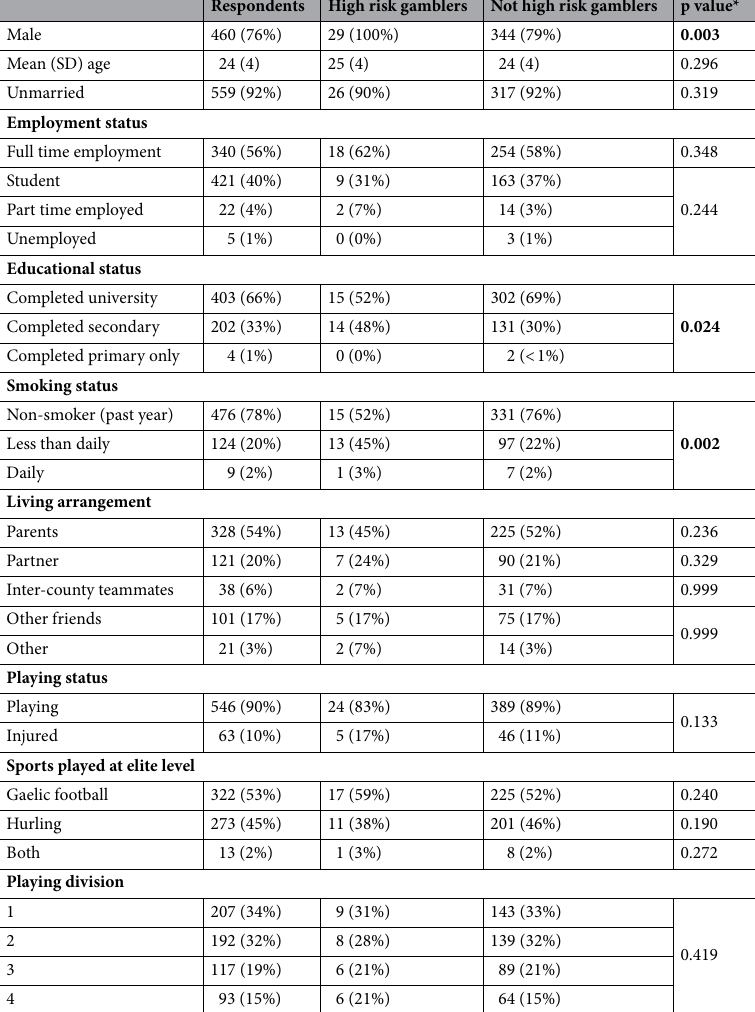
Table 1. Characteristics of study participants. *High risk gamblers versus not. Significant values are in